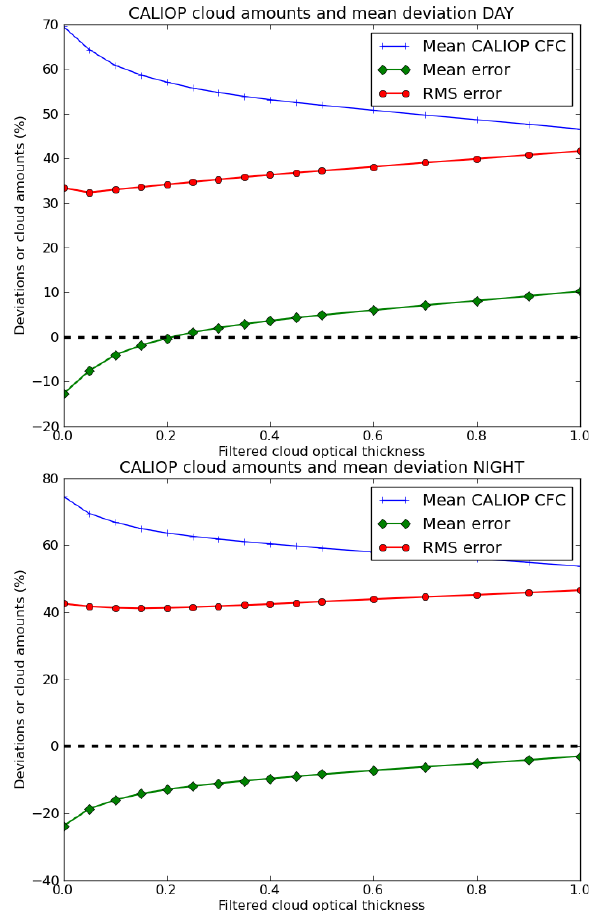
Fig. 10. Same visualisation as in Fig. 7 but for categories day (top) and night